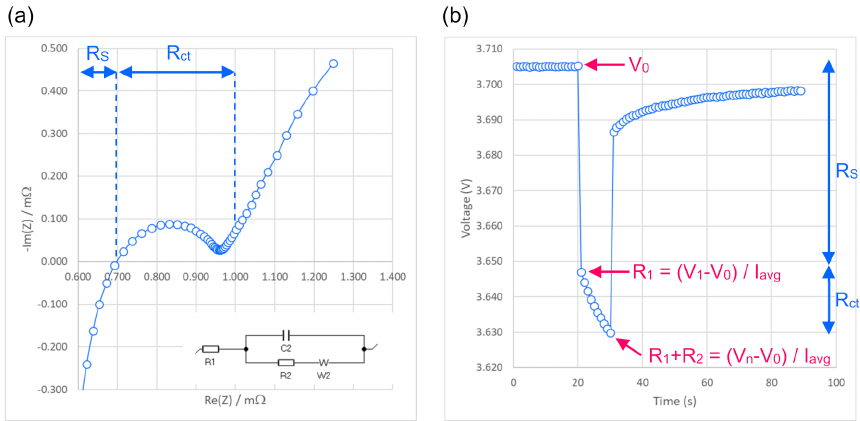
Figure 7. ( a ) Internal resistance of AC-Impedance, ( b ) Internal resistance of